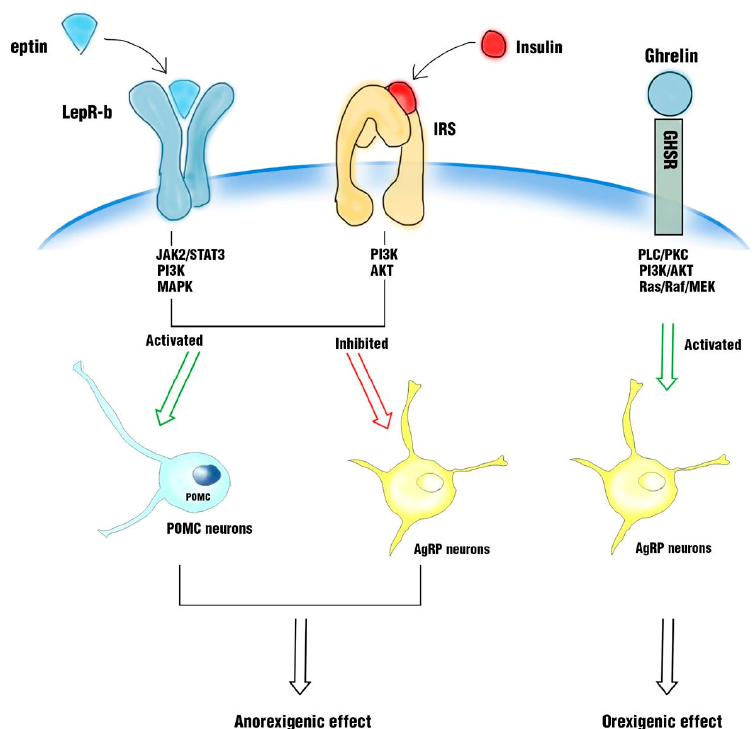
Figure 2. In hypothalamus, leptin exerts an anorexigenic power, binding to its receptor (LepR-b) and activating a signaling pathway, which induces the activation of proopiomelanocortin (POMC) neurons and the inhibition of releasing agouti-related protein (AgRP). The same anorexigenic power is exerted by insulin when it binds to its IRS receptor. In contrast, ghrelin exerts orexigenic effects, binding to the growth hormone secretagogue receptor (GHSR) and promoting hunger, activating AgRP neurons.